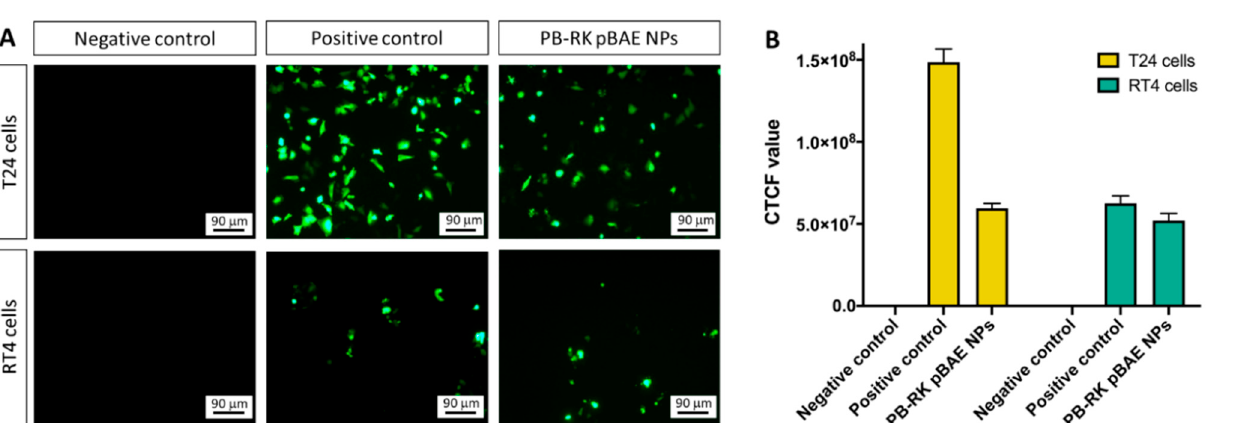
fication of the transfection, given as CTCF values. the transfection, given as CTCF